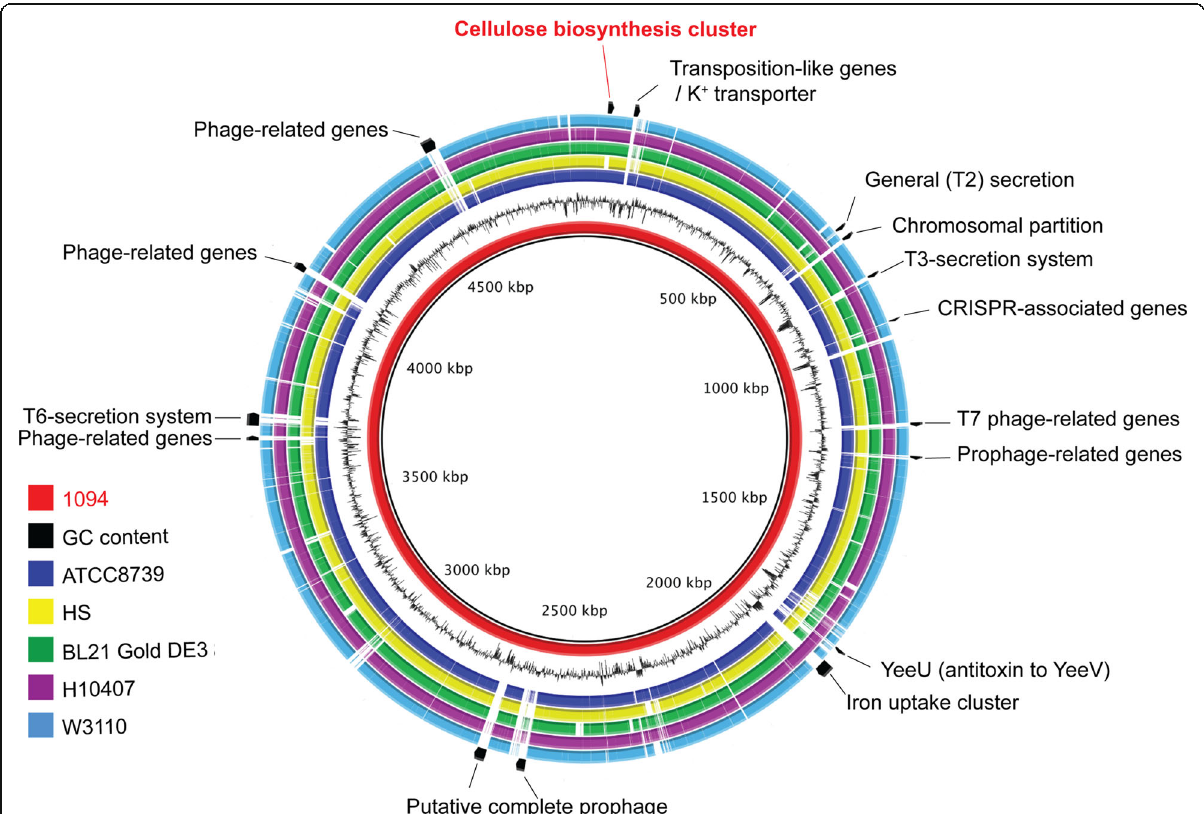
Fig. 4 Circular representation of the E. coli 1094 genome. Genomic comparison of E. coli 1094 genome with the genomes of five other E. coli strains from phylogenetic group A. Each strain is color-coded (bottom-left). Relevant gene clusters and regions unique to E. coli 1094 and are